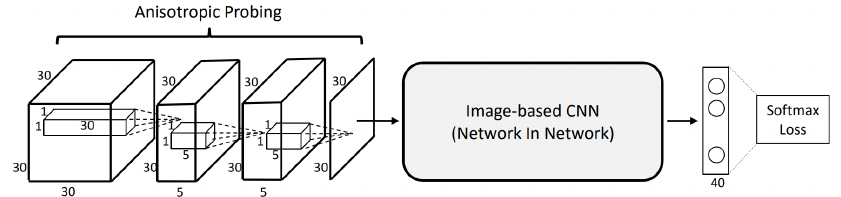
Figure 4. CNN with anisotropic probing kernels. Elongated 3D convolutions are used to first extract features from 3D. The 3D output is subsequently aggregated onto a 2D plane and passed into a 2D Network-in-Network CNN and classified using a softmax layer. Image source: